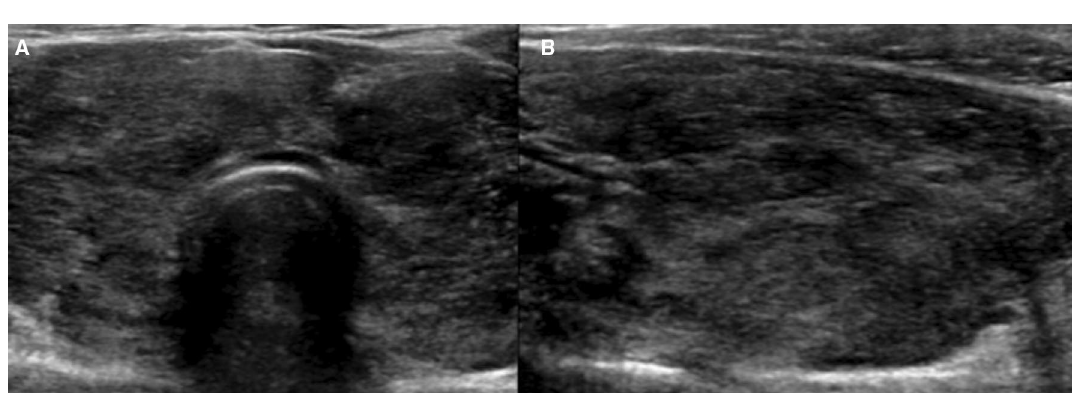
Figure 4. Transverse ( A ) and longitudinal ( B ) US images of G4: diffusely enlarged thyroid gland with diffuse heterogeneity involving more than one third of the gland (area with dashed lines) with marked hypoechogenicity that is more hypoechoic than the anterior strap muscle